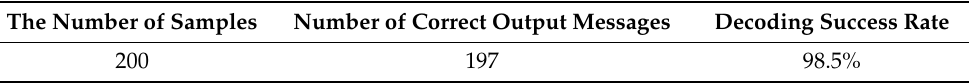
Table 8. Method identification success rate.